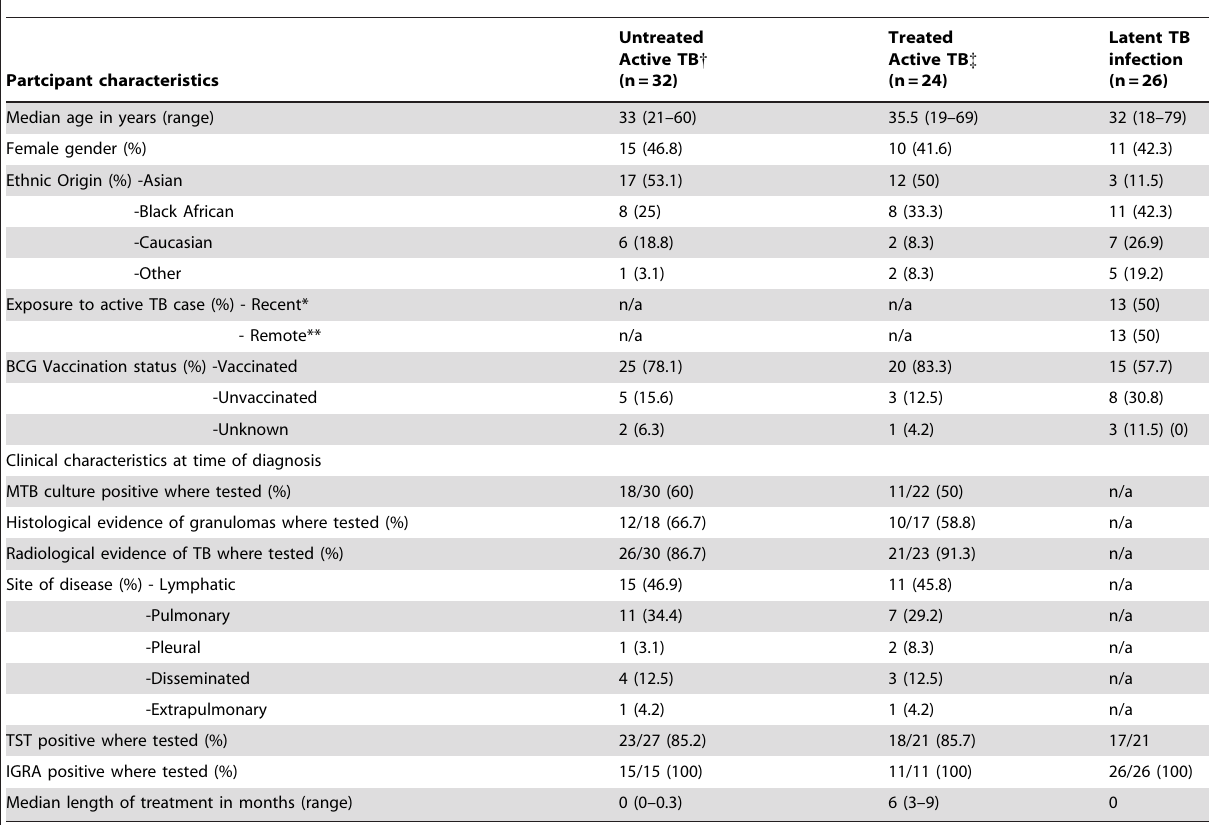
Table 1. Demographic and clinical characteristics of study